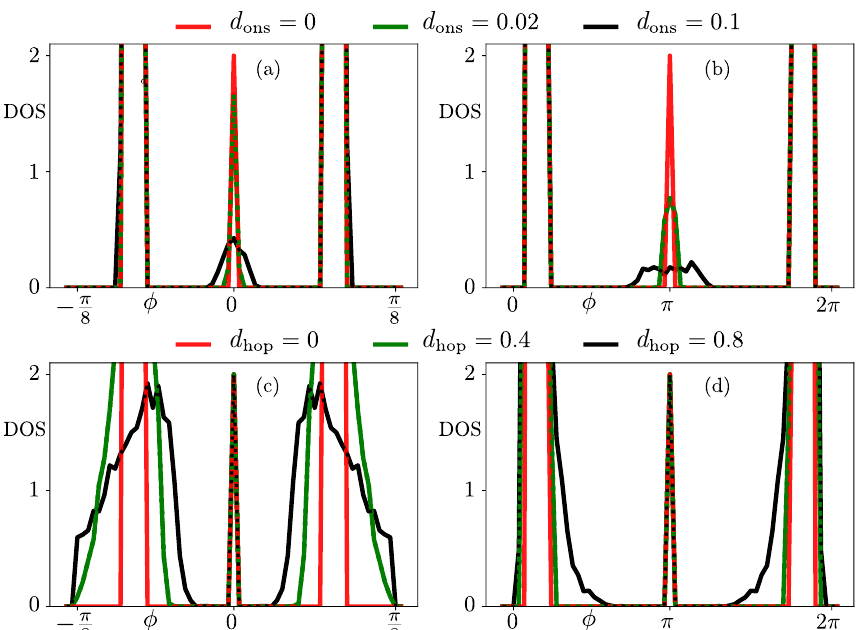
Figure 3: The evolution of the DOS (of the reflection matrix) with disorder. For every disorder realization, we calculate the DOS by dividing the full eigenphase range into 60 equally sized intervals. Panels (a) and (b) concern onsite disorder, while panels (c) and (d) reveal effects of randomness in hopping strengths. In panels (a) and (c), = 1.2, γ = 0.4, λ = λ = 1), we consider a reflection matrix with 0-modes ( γ x y x y while panels (b) and (d) show how disorder influences a reflection matrix with only π -modes ( γ = γ = 0.4, λ = λ = 1). In all cases, the system size is 60 × 60 x y x y